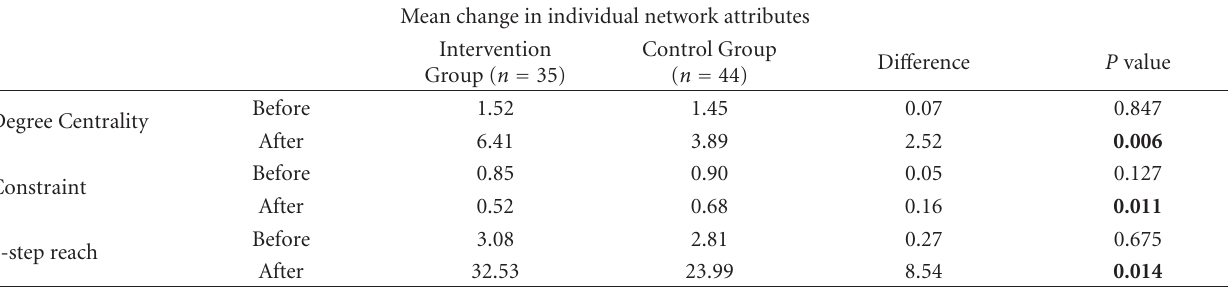
Figure 2: Mapping of social network changes over 3-month intervention. Each graph shows the study participants who have social ties with other study participants. These maps illustrate several points: First, some study participants already knew each other at baseline. This reflects the fact that the most e ff ective recruitment strategy in this Latino population was word of mouth referrals. Importantly, there were no di ff erences in preexisting network ties between control and intervention groups. Second, while some study participants already knew other study participants at baseline, half did not, and thus are not shown here, reflecting the average number of ties of 1.5 at baseline. Third, after the intervention, each group increased in the number of participants who had ties with others in the group. Table 4: T -Tests of goup di ff erences related to individual network attributes.